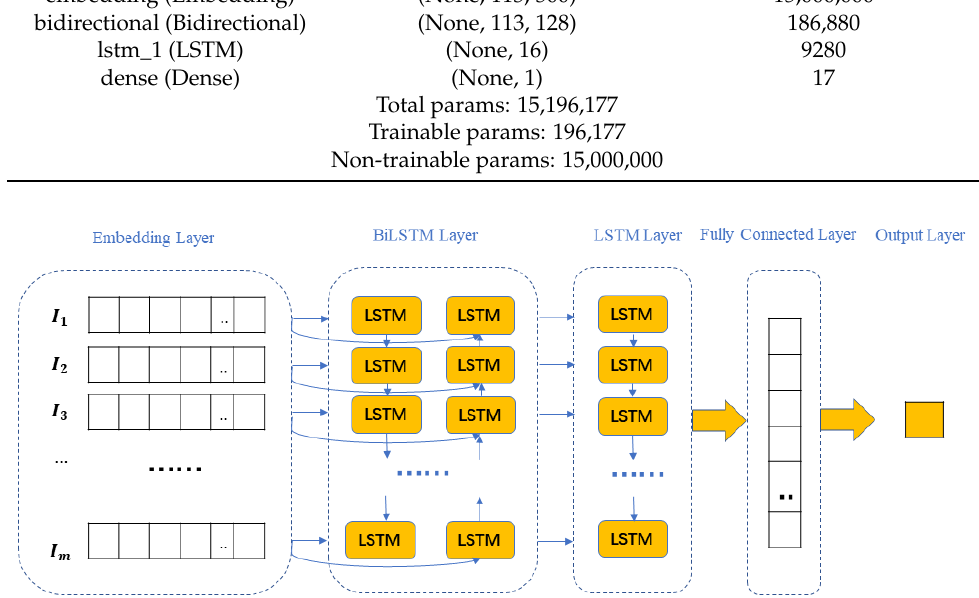
Figure 4. Block diagram of the proposed